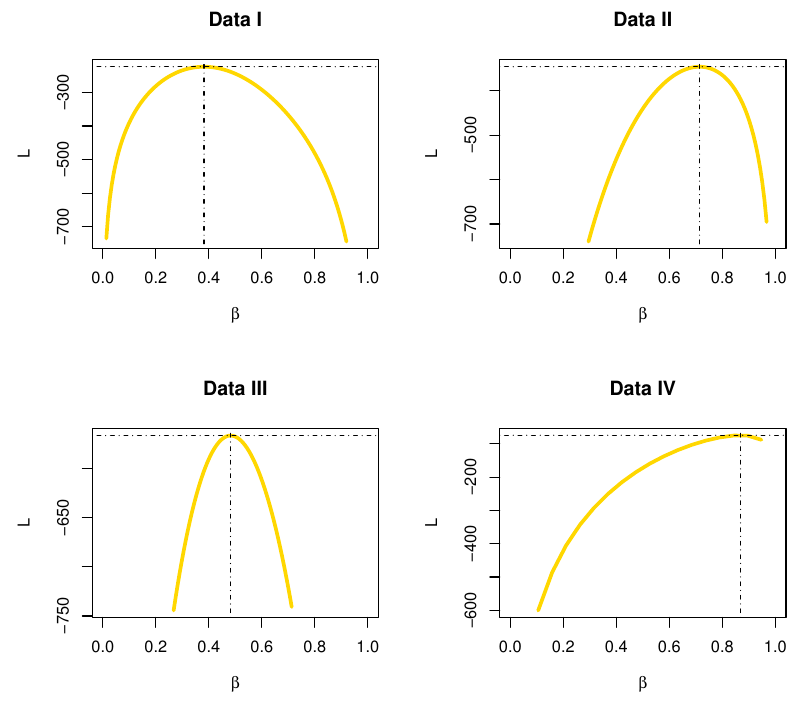
Figure 20. The profiles of L functions for data sets I, II, III and